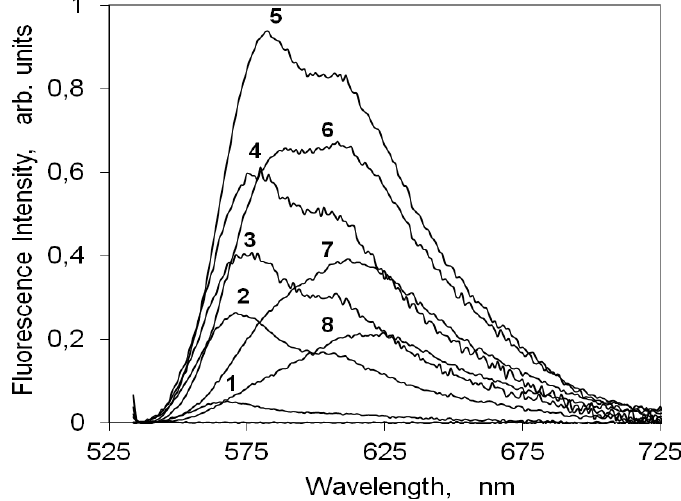
Figure 5. Steady-state emission spectra of the 3,3'-di(2-sulfoethyl)-indocarbocyanine dye on microcrystalline cellulose, excited at 525 nm. The sample concentration is (1) 0.01 microcrystalline